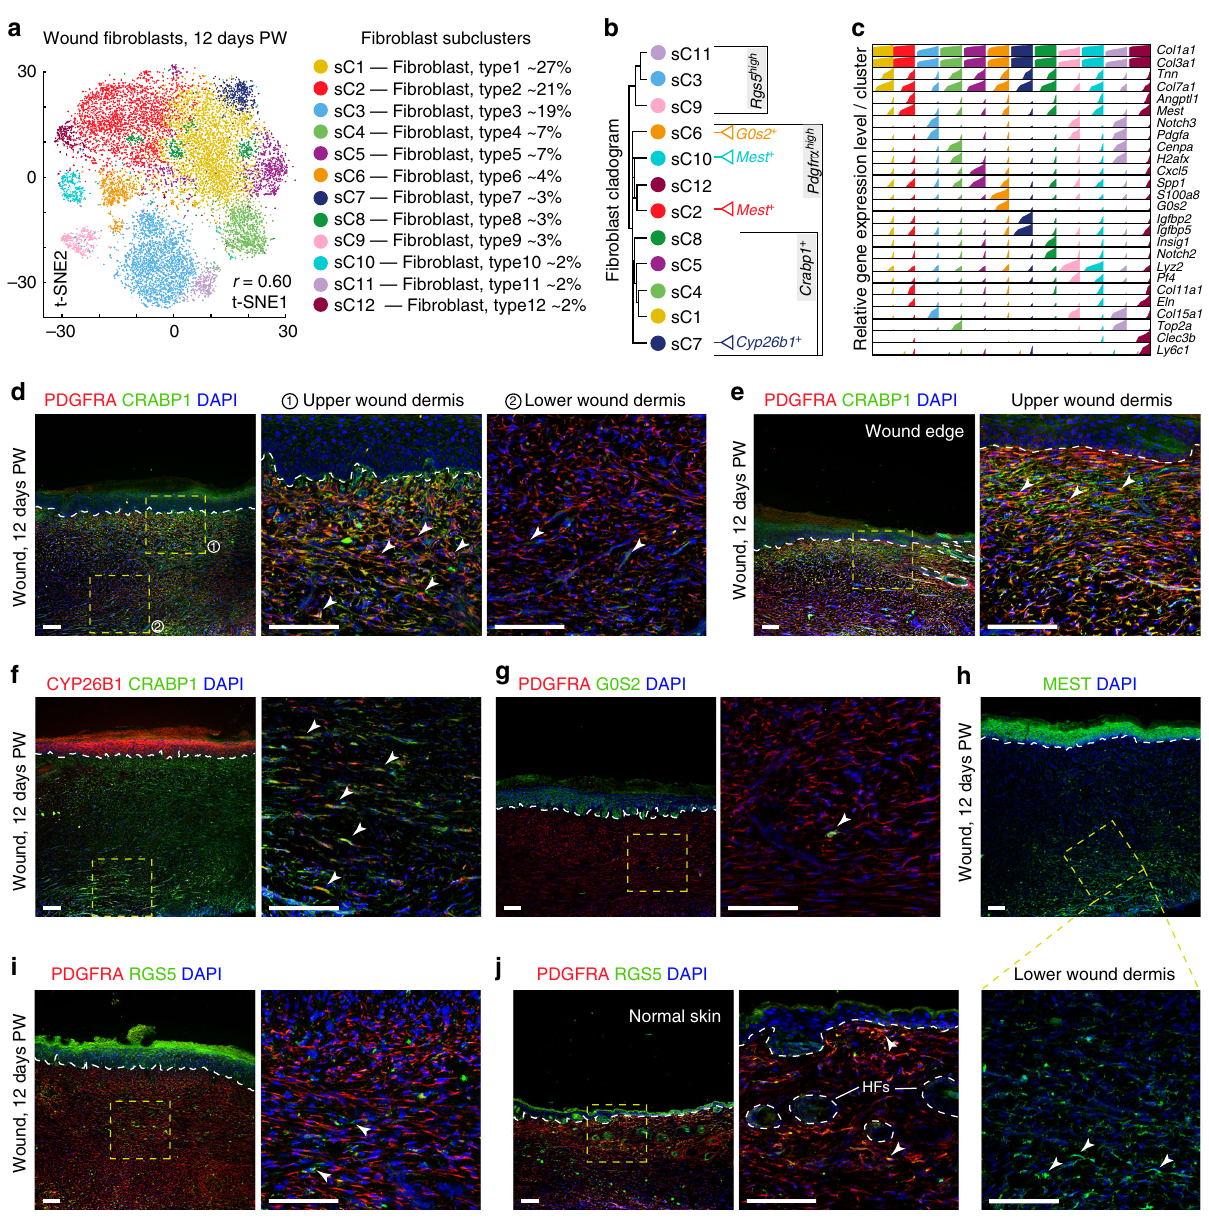
Fig. 2 Subclustering of wound fi broblasts reveals cellular heterogeneity. a Subclustering of wound fi broblasts (cells from clusters C1, C2, C4, C6, and C9 shown in Fig. 1) further identi fi ed 12 distinct subtypes. Color-coded t-SNE plot is shown and each fi broblast subcluster (sC1 through sC12) is de fi ned on the right. b Unsupervised hierarchical clustering showing relatedness of wound fi broblast subclusters. Immunostaining markers speci fi c to individual fi broblast subclusters or groups of subclusters are listed on the right. c Relative expression of selected subcluster-speci fi c genes shown as high-density bar charts. Bar charts are generated analogous to these in Fig. 1f. Two genes are shown per subcluster and subclusters are color-coded to match the colors in a . d – j Staining of day 12 wounds for selected markers. d , e Co-staining for PDGFRA (red) and CRABP1 (green) identi fi es enriched localization of CRABP1 + /PDGFRA + double- positive fi broblasts in the upper wound dermis (arrowheads on inset 1 on d and inset on e ). Lower wound dermis contains large numbers of PDGFRA + single- positive fi broblasts (inset 2 on d ). f Co-staining for CRABP1 (green) and CYP26B1 (red) identi fi es occasional CYP26B1 + /CRABP1 + double-positive fi broblasts (arrowheads on inset). g Co-staining for PDGFRA (red) and G0S2 (green) identi fi es seldom G0S2 + /PDGFRA + double-positive fi broblasts (arrowhead on inset). h Numerous MEST + cells (green) are present in the wound and primarily localize in the lower wound dermis (arrowheads on inset). i Co-staining for PDGFRA (red) and RGS5 (green) identi fi es RGS5 + single-positive fi broblasts present throughout wound dermis (arrowheads on inset). j Normal, unwounded skin contains both RGS5 + single-positive and RGS5 + /PDGFRA + double-positive fi broblasts, especially in the upper dermis (arrowheads on inset). Hair follicles are marked. Immunostaining images shown in this fi gure are representative of the marker staining patterns observed in three or more independently stained samples. PW: post-wounding, HF: hair follicle. Size bars: d – j — 100 µ